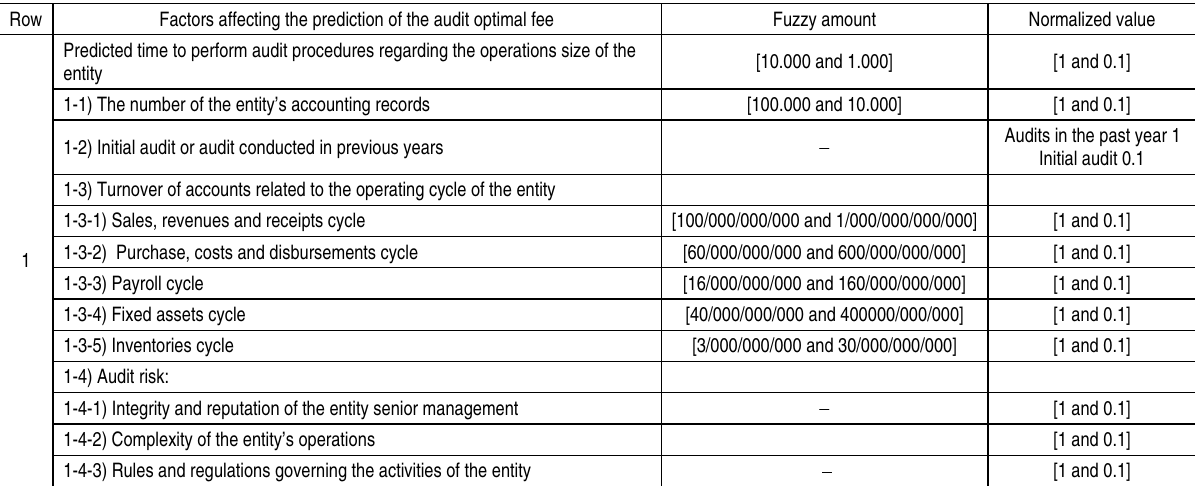
Table 5. Normalized amounts of